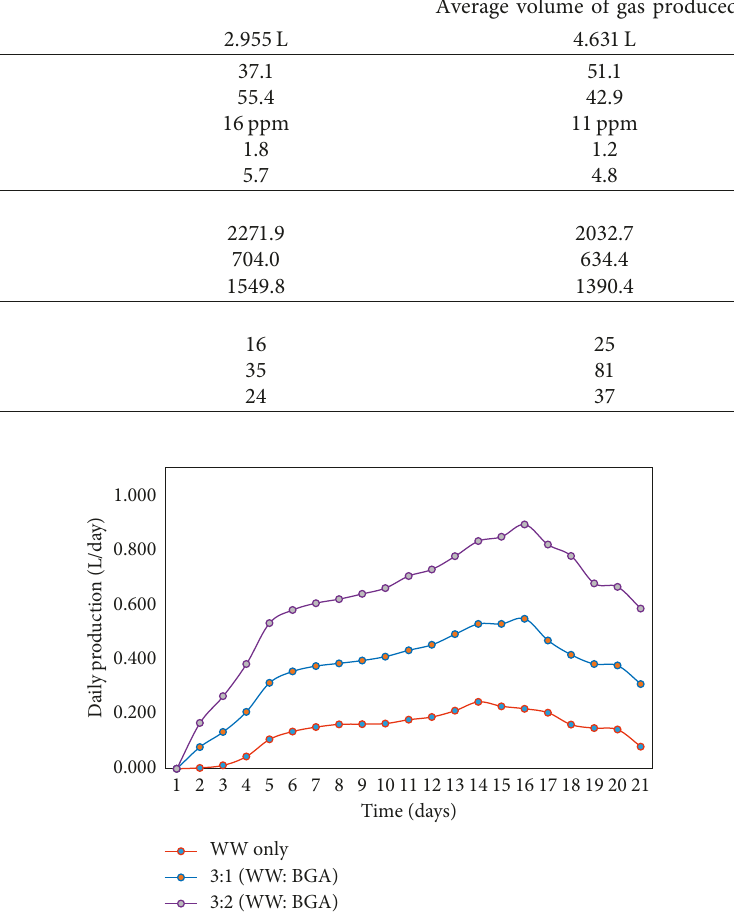
Figure 7: Daily production of each mixing